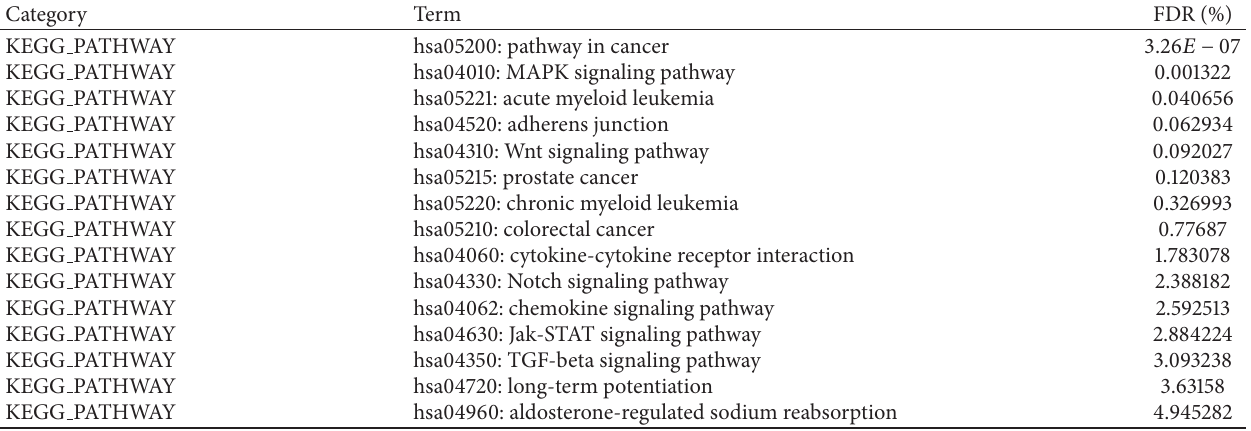
Table 3: Enriched KEGG pathways of differentially regulatory